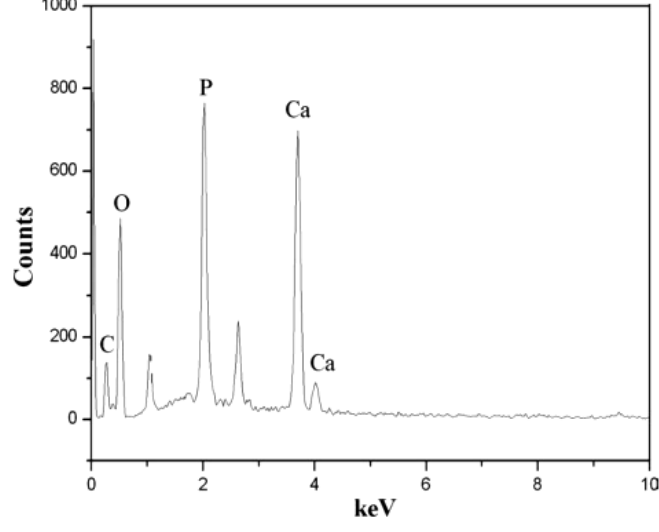
Figure 9. Energy Disperse X-ray Analysis (EDX) patterns of mineralized silk/nHA